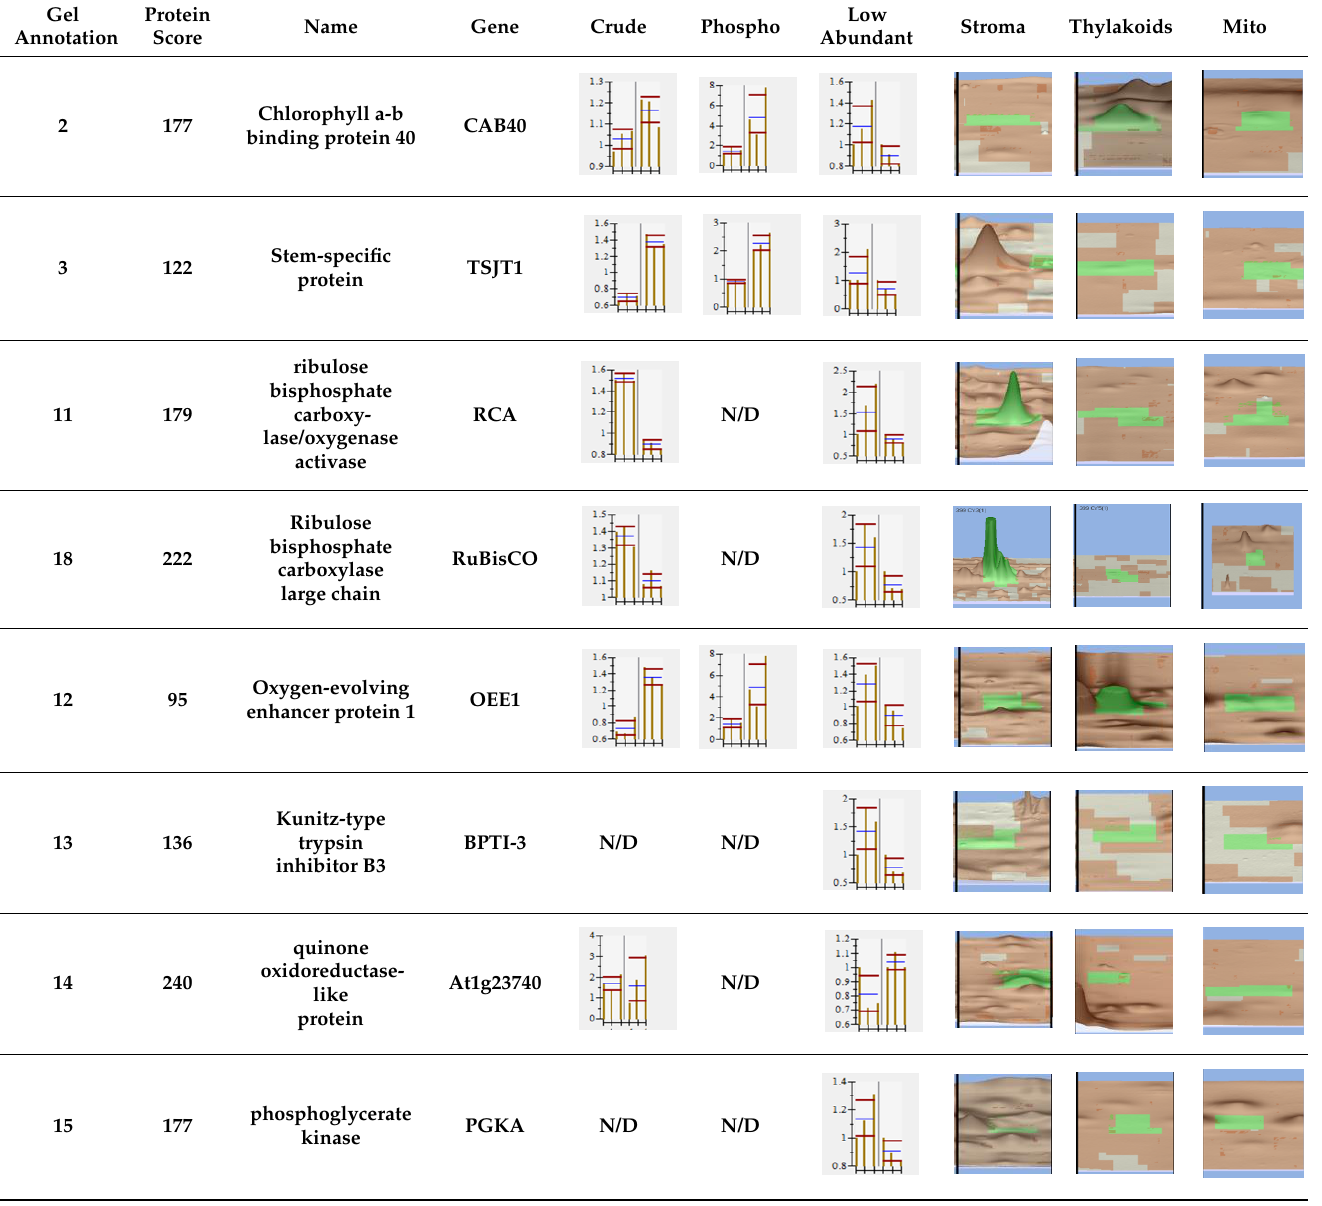
TSJT1 TSJT1 TSJT1